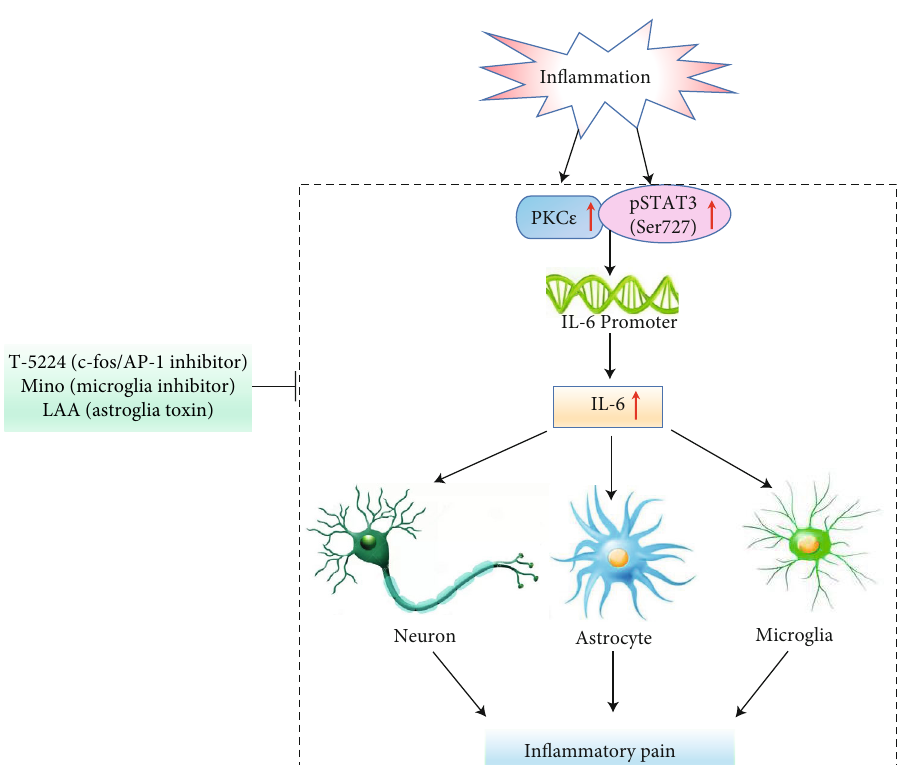
Figure 8: Interaction between PKC ε and STAT3 Ser727 in nociceptive regulation during in fl ammatory pain. PKC ε and STAT3 engaged with IL-6-mediated neuronal and glial cell crosstalk during in fl ammatory nociceptive transmission. Under in fl ammatory conditions, upregulated PKC ε and STAT3 Ser727 phosphorylation interacted in the spinal cord and subsequently increased IL-6 promoter activity that manifested as IL-6 cytokine-mediated in fl ammatory pain. T-5224, Mino, and LAA inhibited the PKC ε /STAT3/IL-6 signaling pathway and the activation of neurons, astrocytes, and glial cells during in fl ammatory pain development. IL-6: interleukin-6; LAA: L-2-aminoadipic acid; Mino: minocycline; PKC ε : protein kinase C epsilon; STAT3: signal transducer and activator of transcription